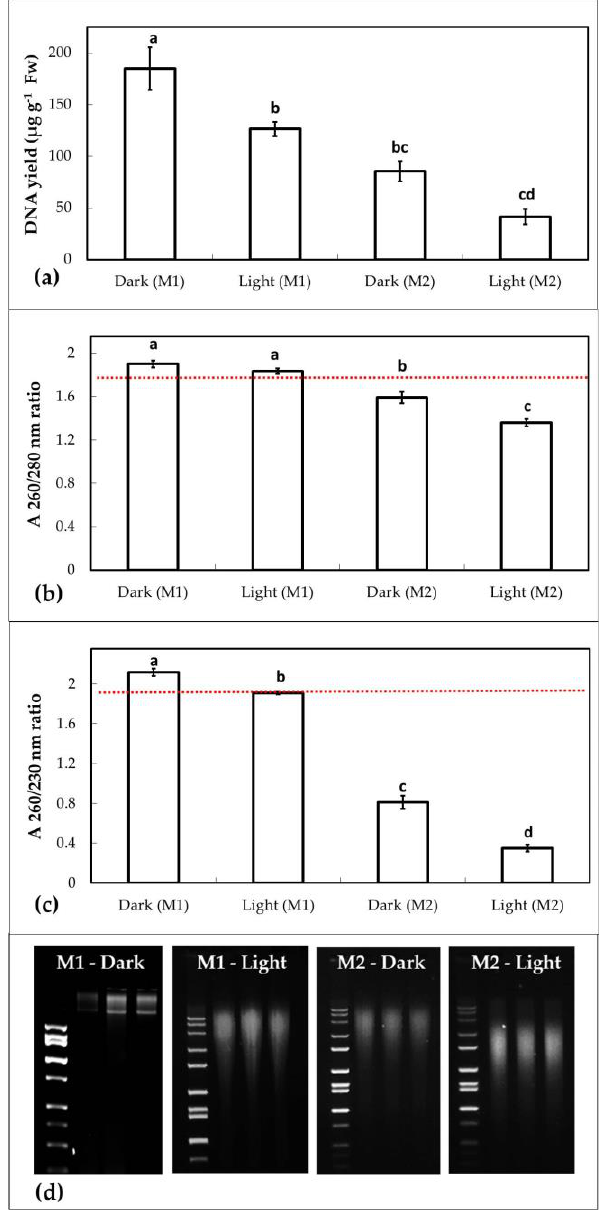
Figure 2. Quantity and quality of DNA extracted from mature pin oak ( Q. palustris ) leaves. ( a ) DNA yield, expressed as µg DNA g −1 fresh weight (Fw); ( b ) A 260/280nm ratios indicative of the presence or absence of protein-type contaminants in the DNA extract and ( c ) A 260/230nm ratios indicative of the presence or absence of carbohydrate or phenolic-type contaminants in the DNA extract were measured and/or calculated based on the absorbance at 230 nm, 260 nm, and 280 nm of DNA extracts prepared from in situ dark- or light-adapted leaves using the extraction methods M1 or M2. The red dotted line on panel ( b ) indicates the 1.8 and panel ( c ) the 1.9 threshold ratio for A 260/280nm and A 260/230nm . Values above those thresholds indicate contaminant free DNA extracts. Data are shown as means ± standard error (SE) of five extractions ( n = 5) each. Quantitative and qualitative differences between DNA extracted from dark- and light-adapted leaves with methods M1 and M2 were analyzed using one-way ANOVA with post-hoc Tukey HSD Test. Significant differences (at p < 0.01) are indicated by letters above bars. Gel images shown in panel ( d ) are indicators of the integrity of genomic DNA extracted using M1 and M2 on dark- and light-adapted mature leaves. The images show representative examples of independent extractions for each method ( n = 3), obtained from dark- or light-adapted leaves. Each lane on the 2% agarose gel containing 0.5 µg/mL ethidium bromide contains 400 ng genomic DNA. DNA size ladders were of 2 kb and 10 kb.